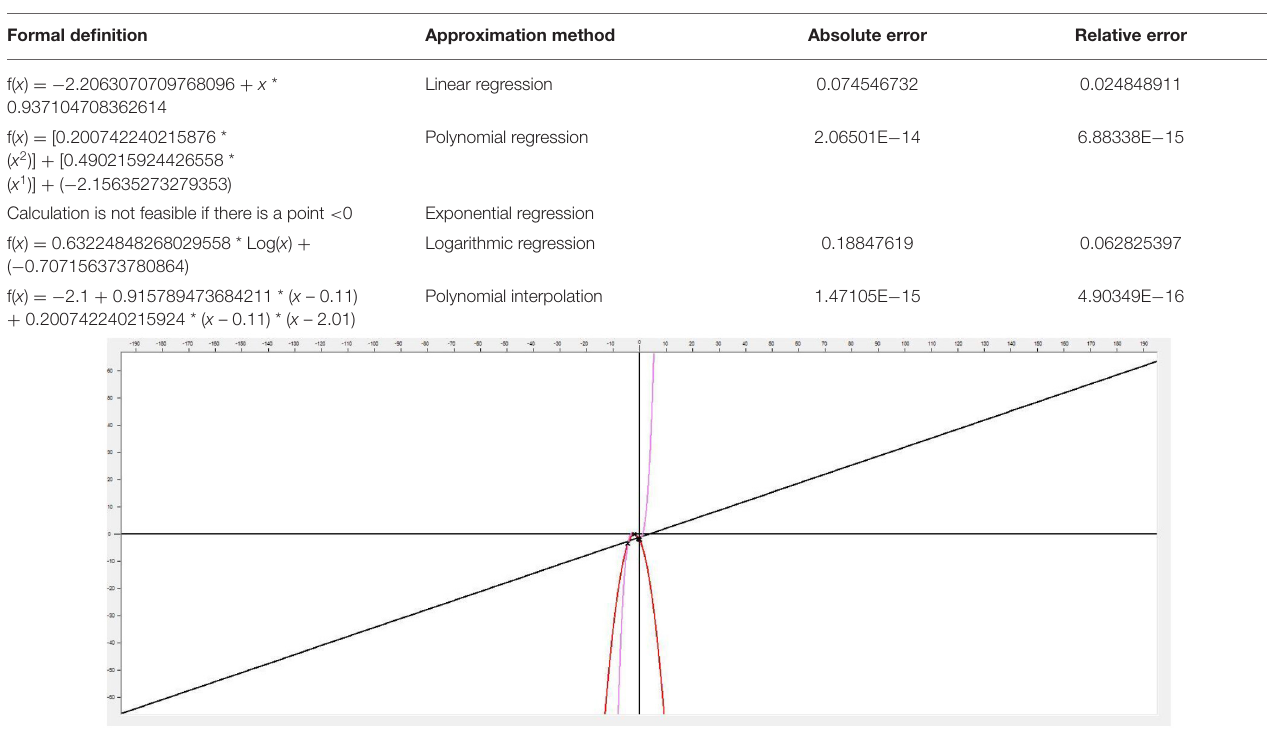
TABLE 9 | Function estimation quadrant IV: focus behavior